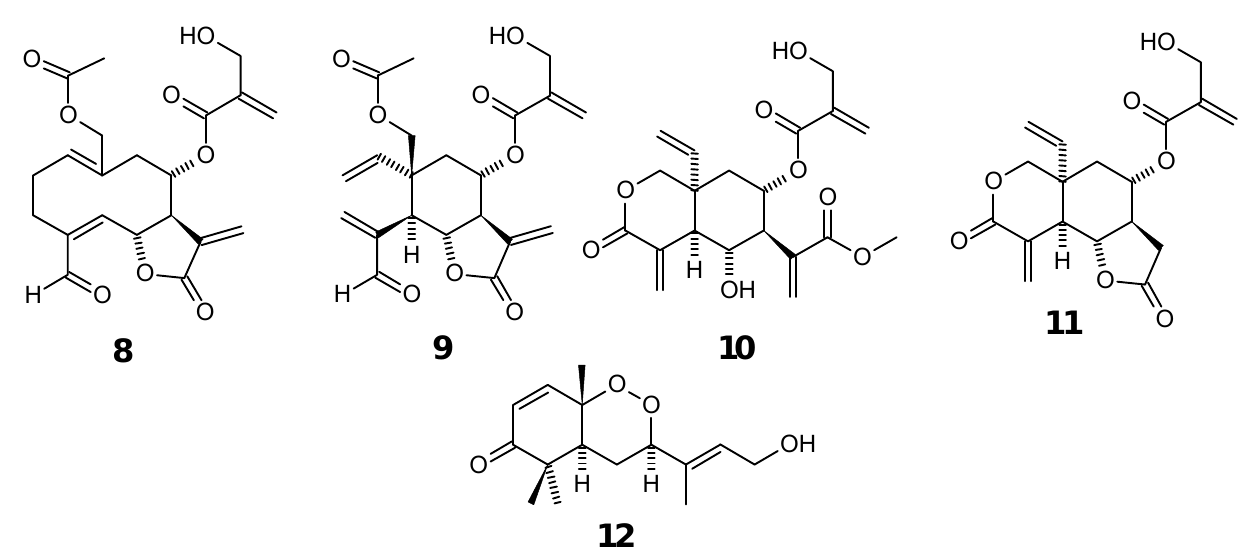
Figure 3. Antiplasmodial terpenes 8 - 12